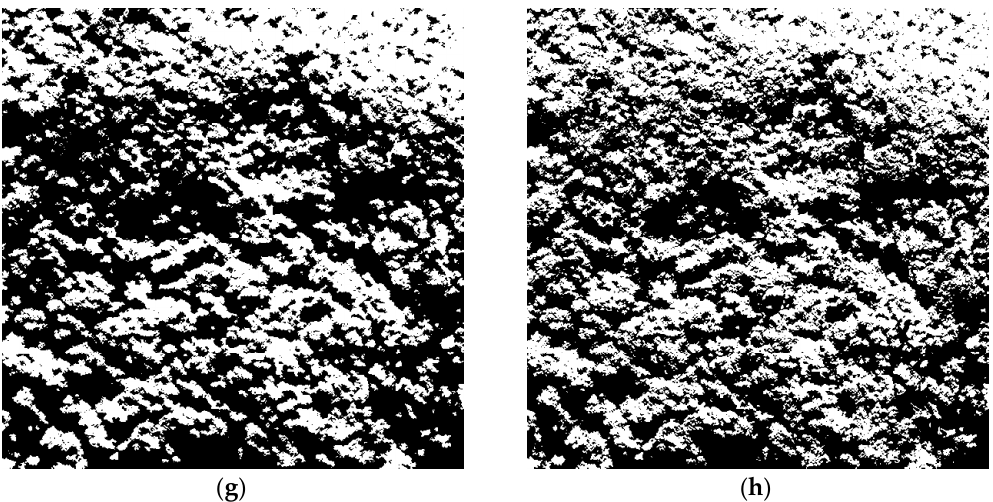
Figure 5. Test image A. ( a ) The original image. ( b ) The reference shadow image. ( c ) Shadow image by the spectral ratio index (SRI)-based algorithm [11]. ( d ) Shadow image by the normalized saturation value difference index (NSVDI)-based algorithm [18]. ( e ) Shadow image by the modified C3 (MC3)-based algorithm [20]. ( f ) Shadow image by the shadow intensity (SI)-based algorithm [14]. ( g ) Shadow image by the shadow detector index (SDI)-based algorithm [19]. ( h ) Shadow image by the developed mixed property-based shadow index (MPSI)-based approach.